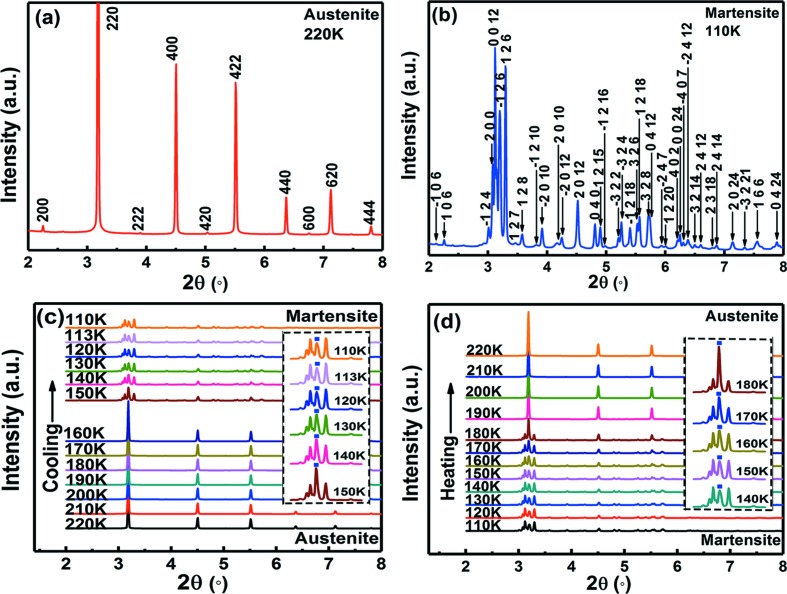
(a), (b) 1D HEXRD patterns of the Ni43.7Cu1.5Co5.1Mn36.7In13 microwire collected at (a) 220 K and (b) 110 K during cooling, and the indexing of the patterns. The 1D patterns are obtained by integrating the 2D patterns along all azimuth angles. (c), (d) Evolution of the HEXRD patterns during (c) cooling from 220 to 110 K and (d) heating from 110 to 220 K. The insets in (c) and (d) show magnified views of the patterns in the 2θ range between 2.9° and 3.7°. The blue squares denote the {220} peak of austenite and the {−126} peak of martensite.